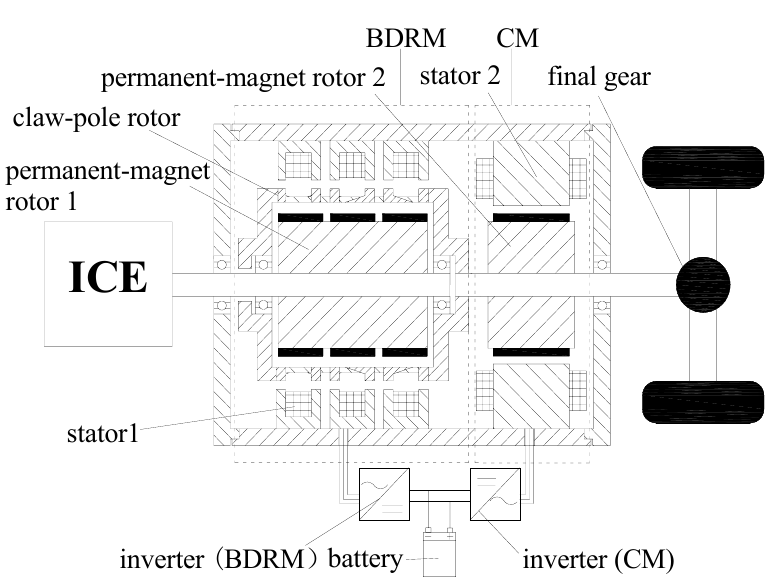
Figure 2. Brushless CS-PMSM system.